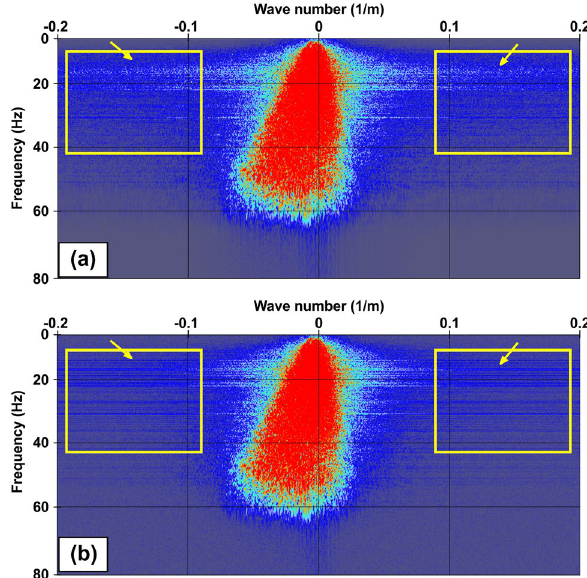
Fig. 7 A frequency-wavenumber cross plot: a before and b after applying the DSMF, revealing that the random (higher frequen- cies) noises are effectively eliminated, as indicated by yellow arrows within yellow